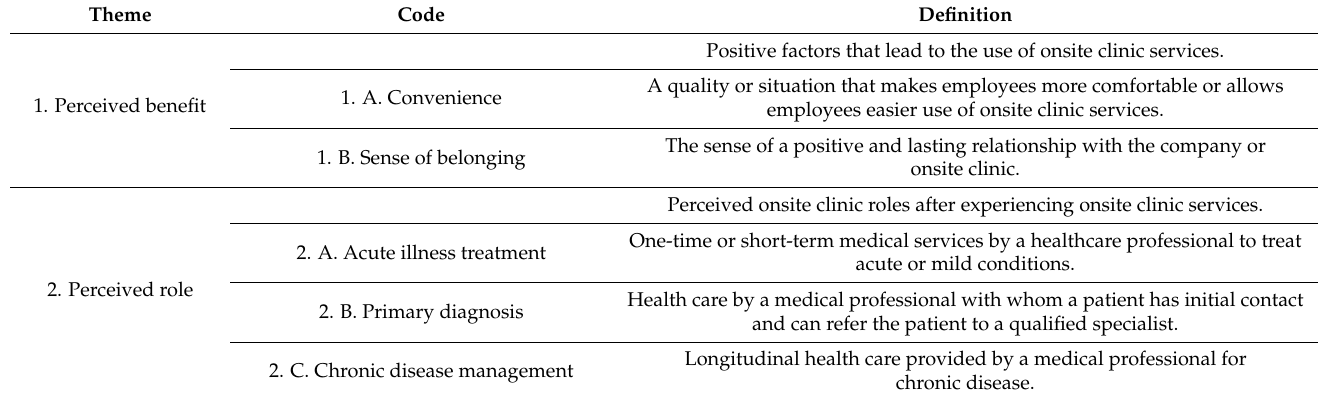
Table 3. Thematic categories and